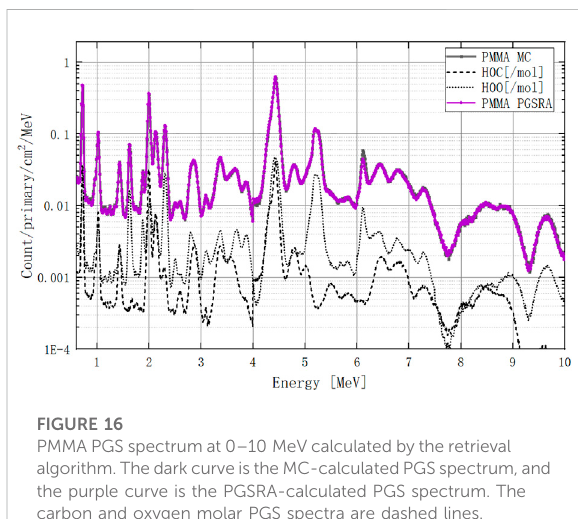
FIGURE 16 PMMA PGS spectrum at 0 – 10 MeV calculated by the retrieval algorithm.ThedarkcurveistheMC-calculatedPGSspectrum,and the purple curve is the PGSRA-calculated PGS spectrum. The carbon and oxygen molar PGS spectra are dashed